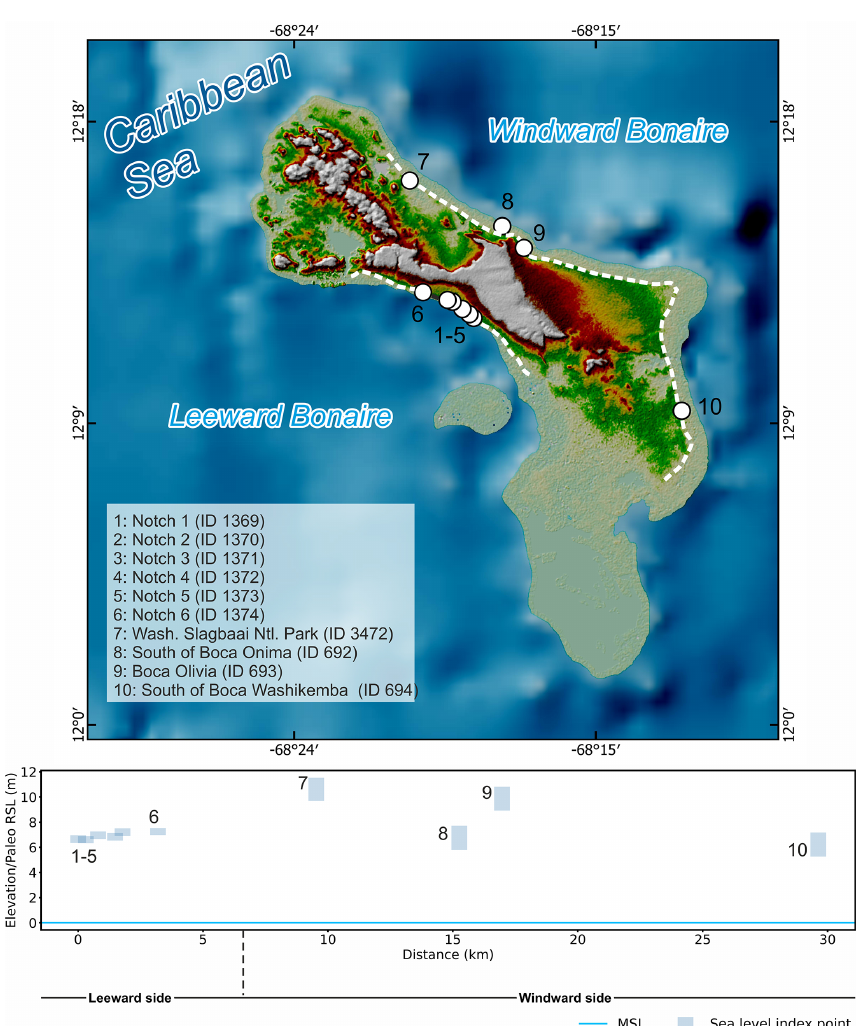
Figure 7. Last interglacial sea-level data in Bonaire. Upper panel: map of sites. The dashed line shows the location of the last interglacial terrace. Basemap compiled with data from GEBCO (https://doi.org/10.5285/836f016a-33be-6ddc-e053-6c86abc0788e) and SRTM 30m by NASA EOSDIS Land Processes Distributed Active Archive Center (LP DAAC, https://lpdaac.usgs.gov/). Lower panel: distance–elevation